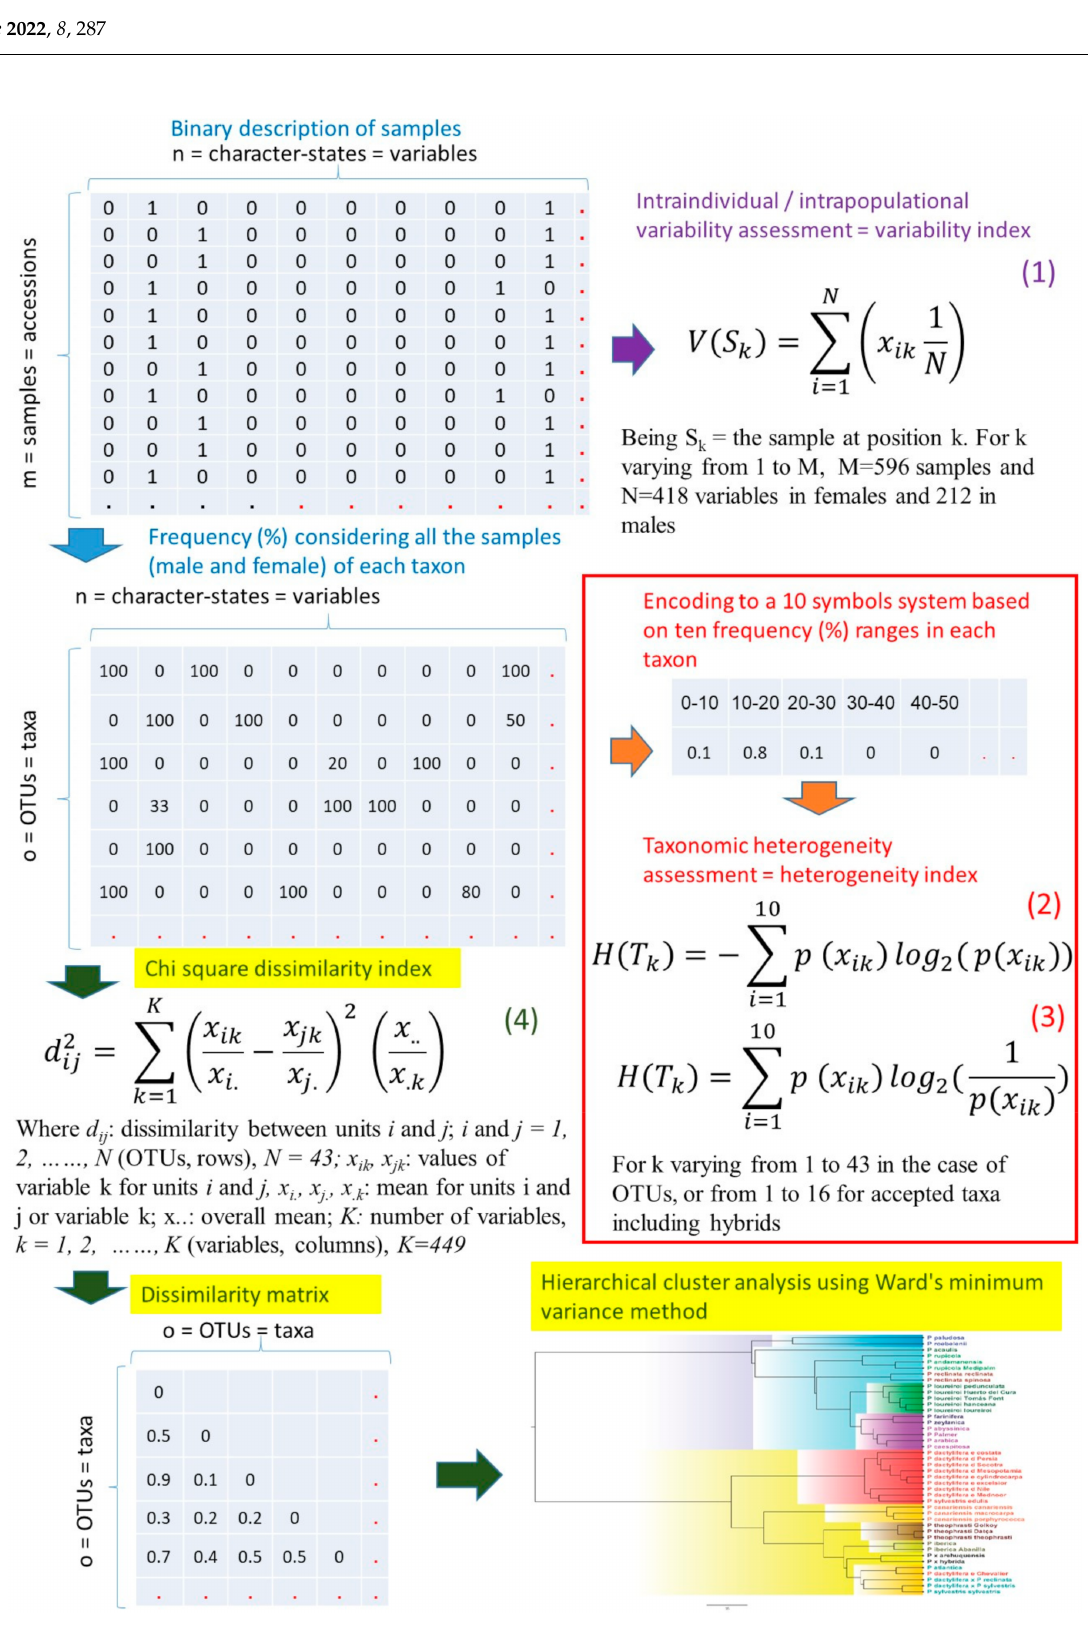
Figure 6. Diagram of the sequence of analysis. With redundancy, we have a measure of predictability that varies from 1 for total order to 0 for total disorder. However for other authors [14], redundancy is a composite concept combining true redundancy and partial